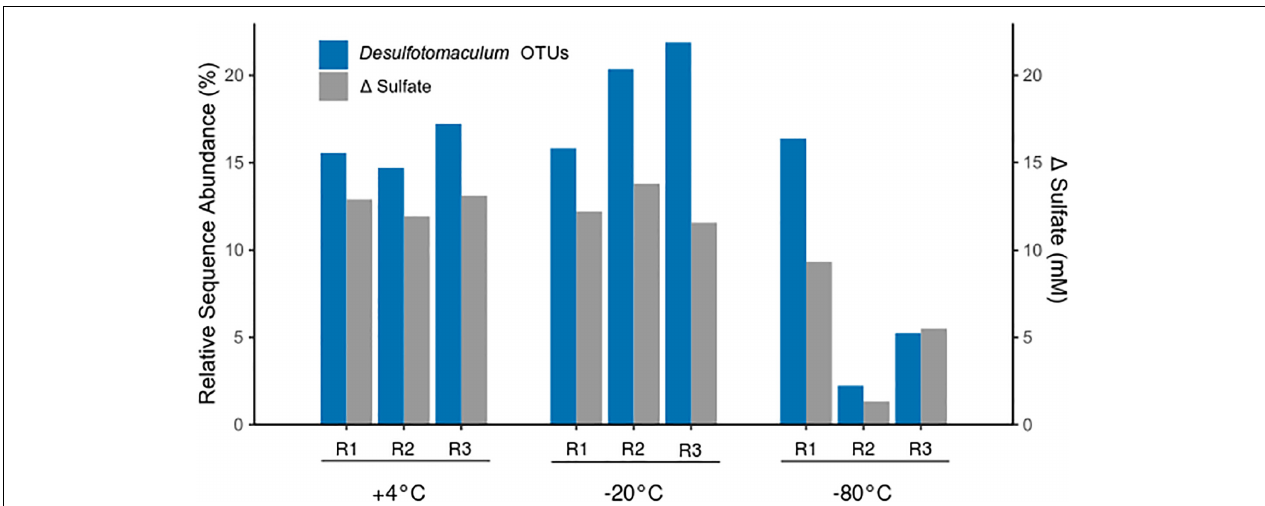
FIGURE 5 | Relative sequence abundance of thermospore OTUs within the genus Desulfotomaculum after 7 days of incubation at +50 ◦ C (left Y -axis), and the corresponding amount of sulfate consumed during the first 10 days of incubation (right Y -axis). Replicates are identified as R1, R2, and R3. The relative sequence abundance of Desulfotomaculum OTUs before high-temperature incubation (i.e., day 0) was on average < 0.005% in all microcosms (not shown).